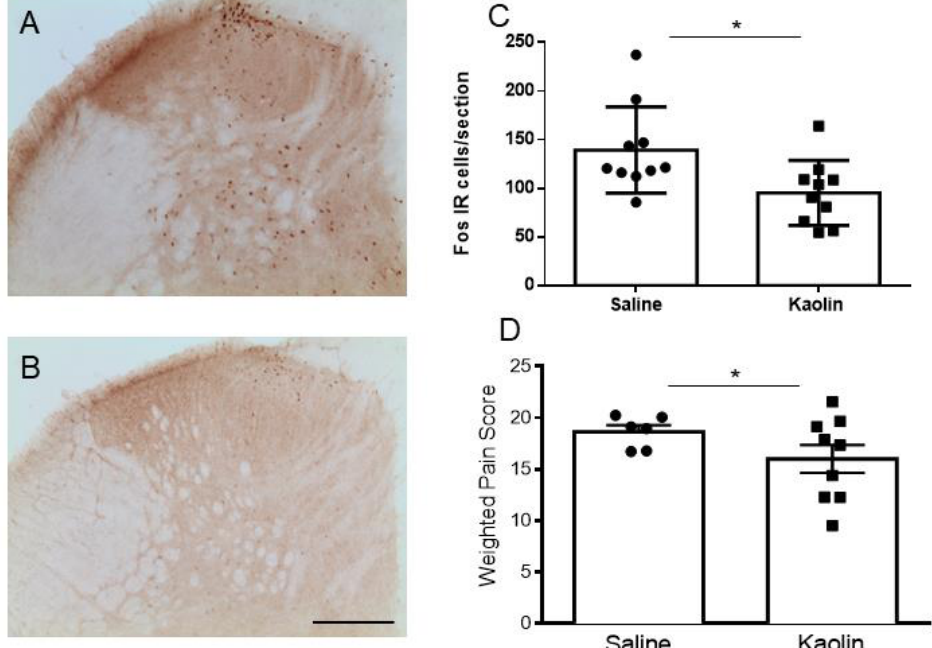
Figure 5. Results of the formalin-induced Fos expression ( A – C ) and nociceptive behaviors ( D ). Representative photomicrographs of Fos-IR neurons in the spinal cord after saline ( A ) or kaolin ( B ) injection. Hydrocephalic animals presented a significant reduction in c-Fos expression in the spinal dorsal horn ( C ). Saline n = 10; Kaolin n = 10. Scale bar: 200 µm; ( A , B ) are at the same magnification. Graph ( D ) shows the nociceptive behavioral responses in the second phase of the formalin test. Kaolin-injected animals showed a decrease in pain behaviors during the second phase of the formalin test. Saline n = 6; Kaolin n = 9. Data in ( C , D ) are presented as means ± SEM. * p < 0.05.